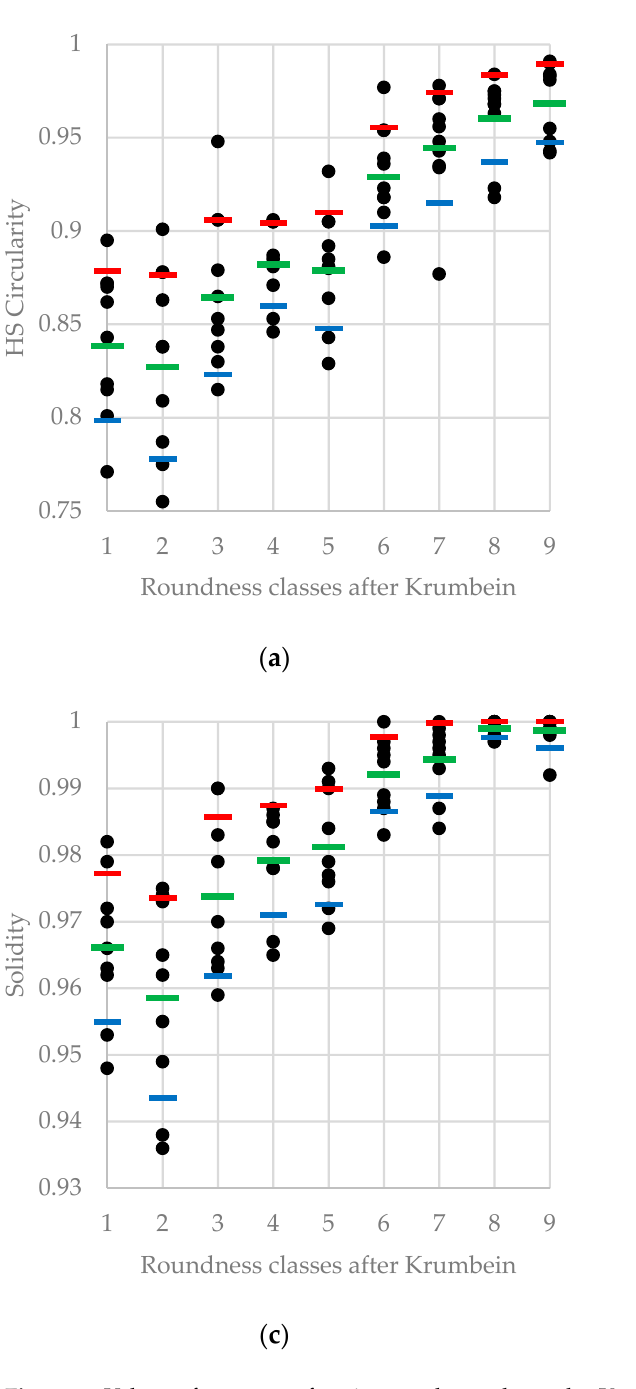
Figure 3. Values of patterns of grain roundness classes by Krumbein [4]: ( a ) HS Circularity; ( b ) Convexity; ( c ) Solidity; ( d ) Aspect Ratio. Red marker: AVG + SD, blue marker: AVG − SD, green marker: AVG.